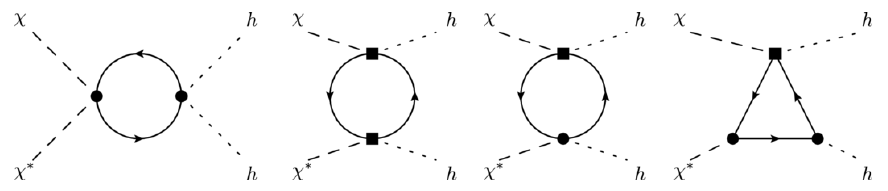
Figure 8 . Representative set of 1-loop diagrams that contribute to the renormalization of the (cid:31) (cid:3) (cid:31)hh interaction at O ( p 2 ). The circles indicate non-derivative interactions arising from elementary-composite mixing terms, whereas the squares denote derivative couplings originating from the e (cid:22) symbol (see eq.